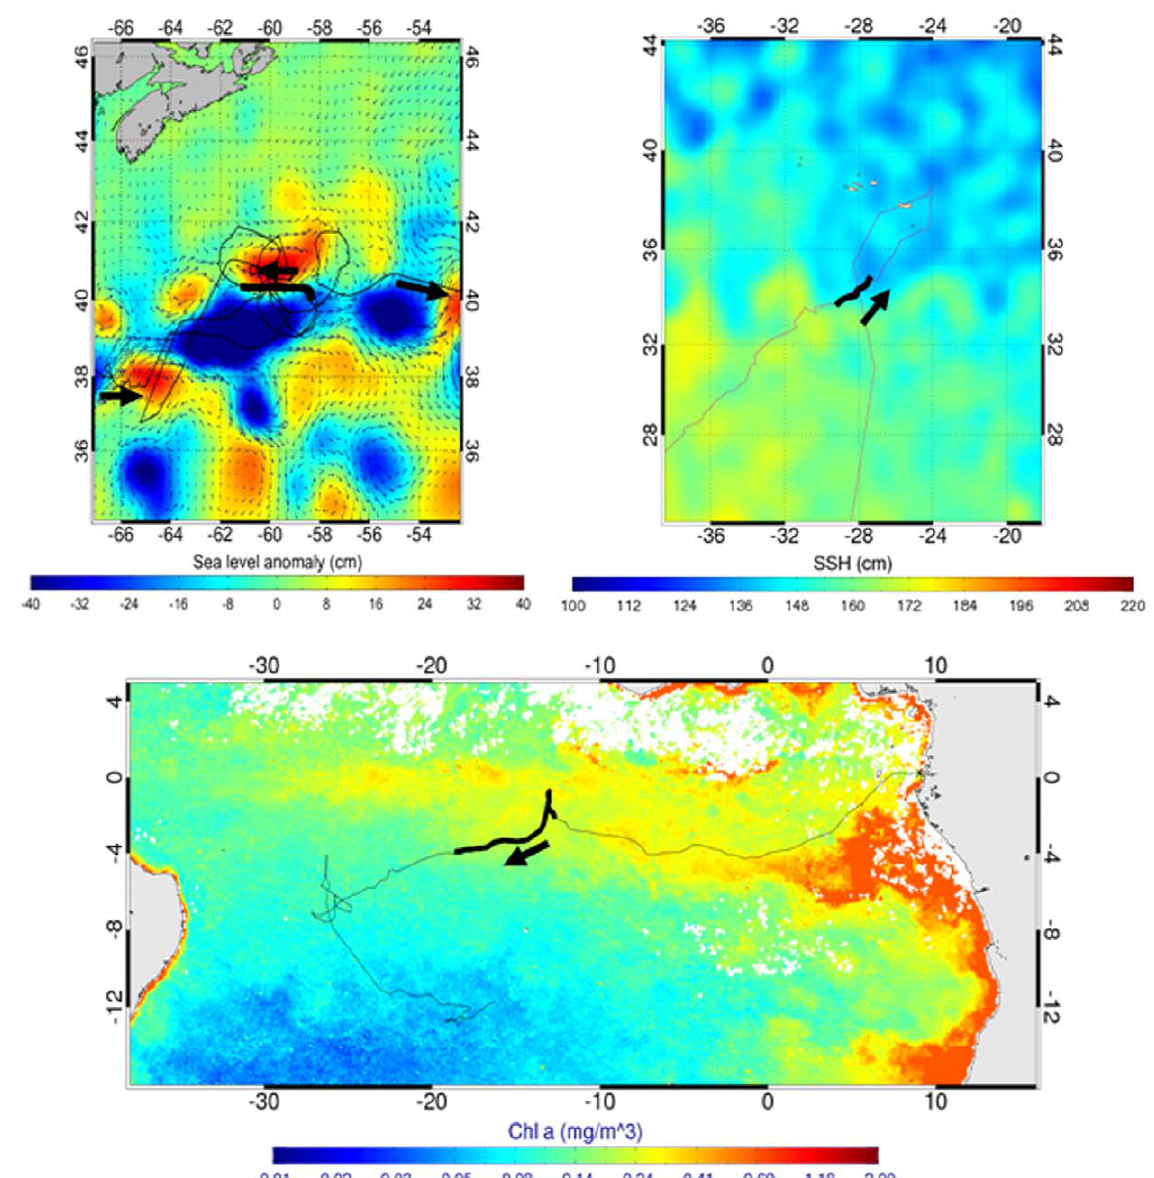
Figure 4. Migration paths and oceanographic parameters. a- Migration path in relation to weekly sea level anomaly (MSLA) of an Argos- tracked leatherback turtle (PA05-2) nesting in Panama in July 2005. The fine line represents the turtle’s track from 10/10/2005 to 20/02/2006 (TRA11), while the bold line represents the week from the 30/12/2005 to the 06/01/2006 concurrent to MSLA map. b- Migration path in relation to weekly absolute dynamic topography (MADT) of an Argos-tracked leatherback turtle (FG05-2) nesting in French Guiana in July 2005. The fine line represents the turtle’s track from 01/10/2005 to 24/02/2006 while the bold line represents the week from the 25/10/2005 to the 01/11/2005 (TRA 1) concurrent to MADT map. c- Migration path in relation to chlorophyll a surface concentration of an Argos-tracked leatherback turtle (GA06-1) nesting in Gabon in March 2006. The fine line represents the turtle’s track from 04/03/2006 to 21/02/2007 while the bold line represents the period from the 01/06/2006 to the 30/06/2006 (TRA 13) concurrent to [Chla]